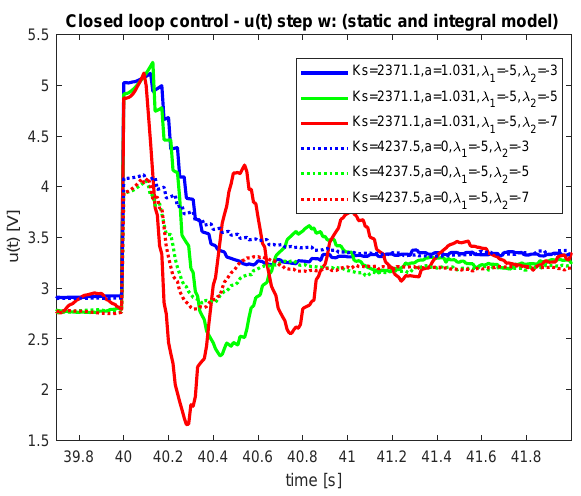
Figure 12. Comparison—setpoint step—control signal.